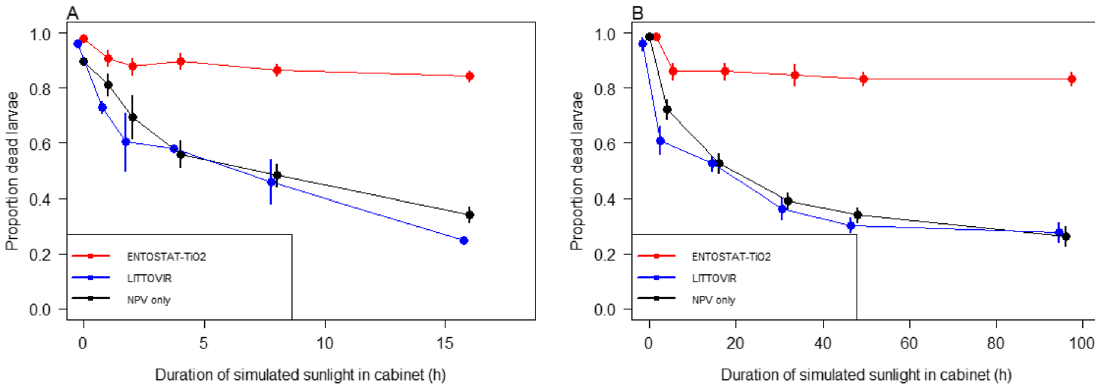
Figure 1. Efficacy of different NPV formulations following exposure to simulated sunlight in an ATLAS SUNTEST XLS + cabinet on glass slides for up to ( A ) 16 h and ( B ) 96 h. In both ( A ) and ( B ), three formulations were tested: non-formulated NPV (black symbols and lines), a commercial standard, LITTOVIR (blue symbols and lines), and NPV formulated in ENTOSTAT wax with Titanium dioxide, TiO 2 additive (red symbols and lines). Symbols indicate the means and bars are ± S.E. Symbols are staggered slightly for clarity. The equivalent hourly dose of UV is 234 kJ m −2